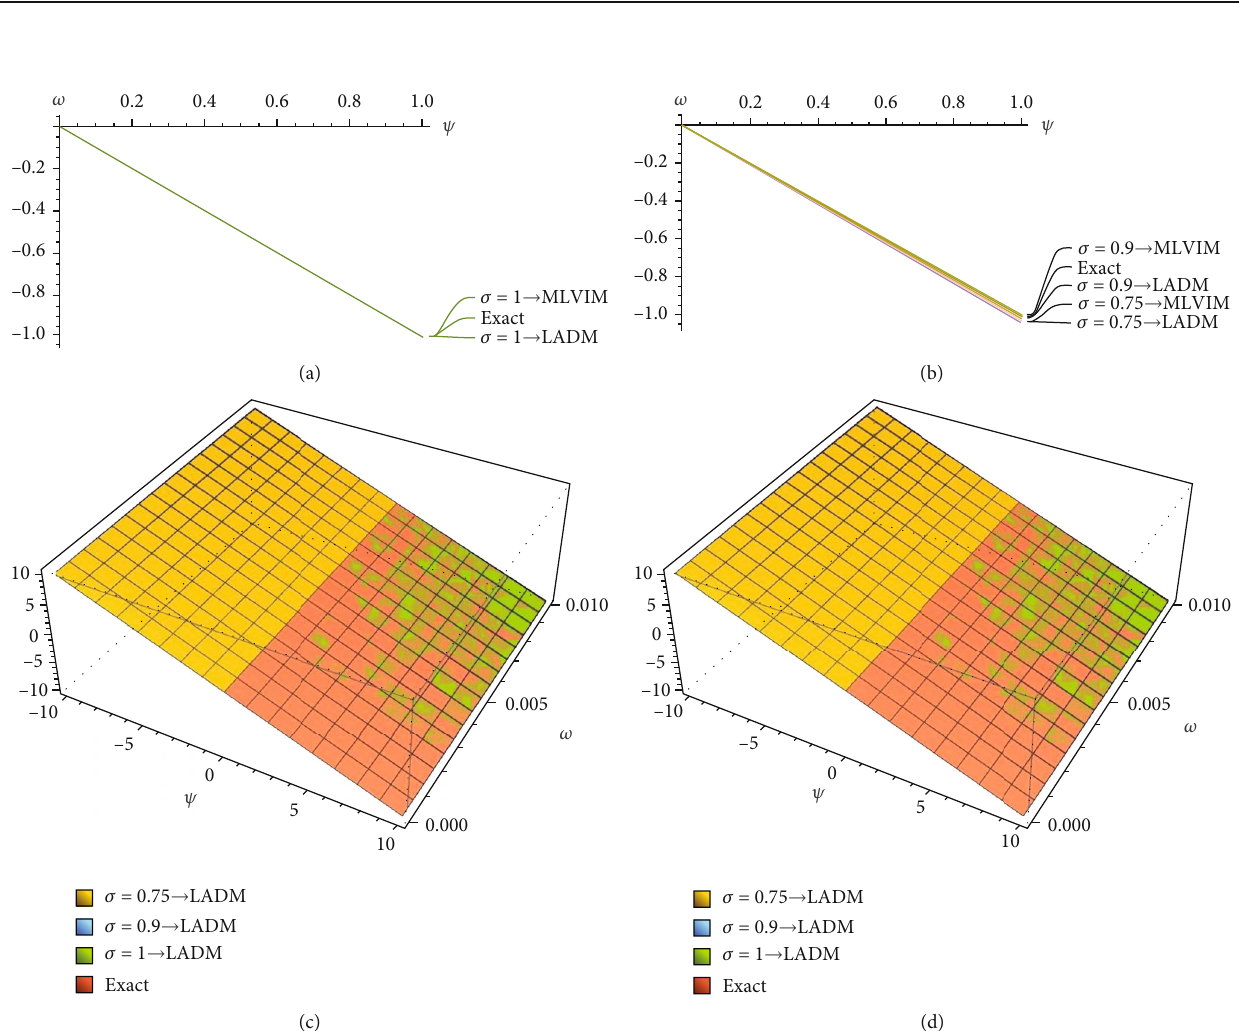
Figure 2: Comparison of LADM and MLVIM solution for the fi rst three approximations with exact solution for ω = 0 : 01 , with mesh points ψ = 0 : 1 , for equation